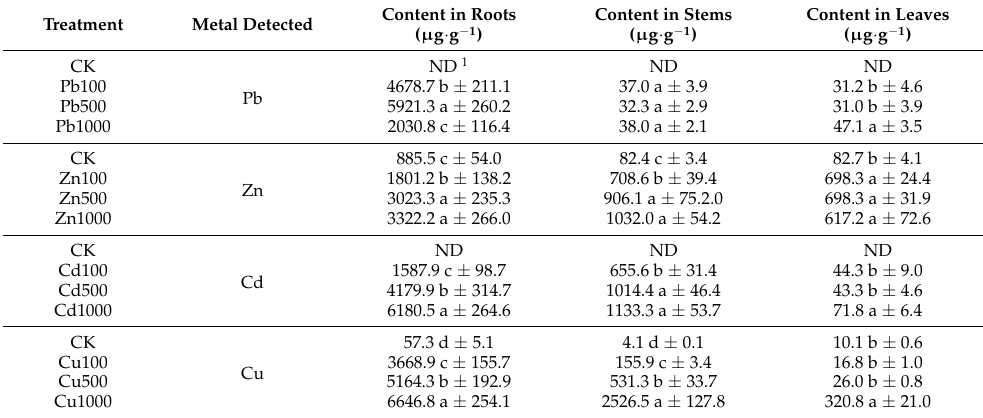
Table 1. Contents of Pb, Zn, Cd, and Cu in roots, stems, and leaves of M. cordata under control (CK) and different concentrations of Cd, Pb, Cu, and Zn after 20 days of exposure.